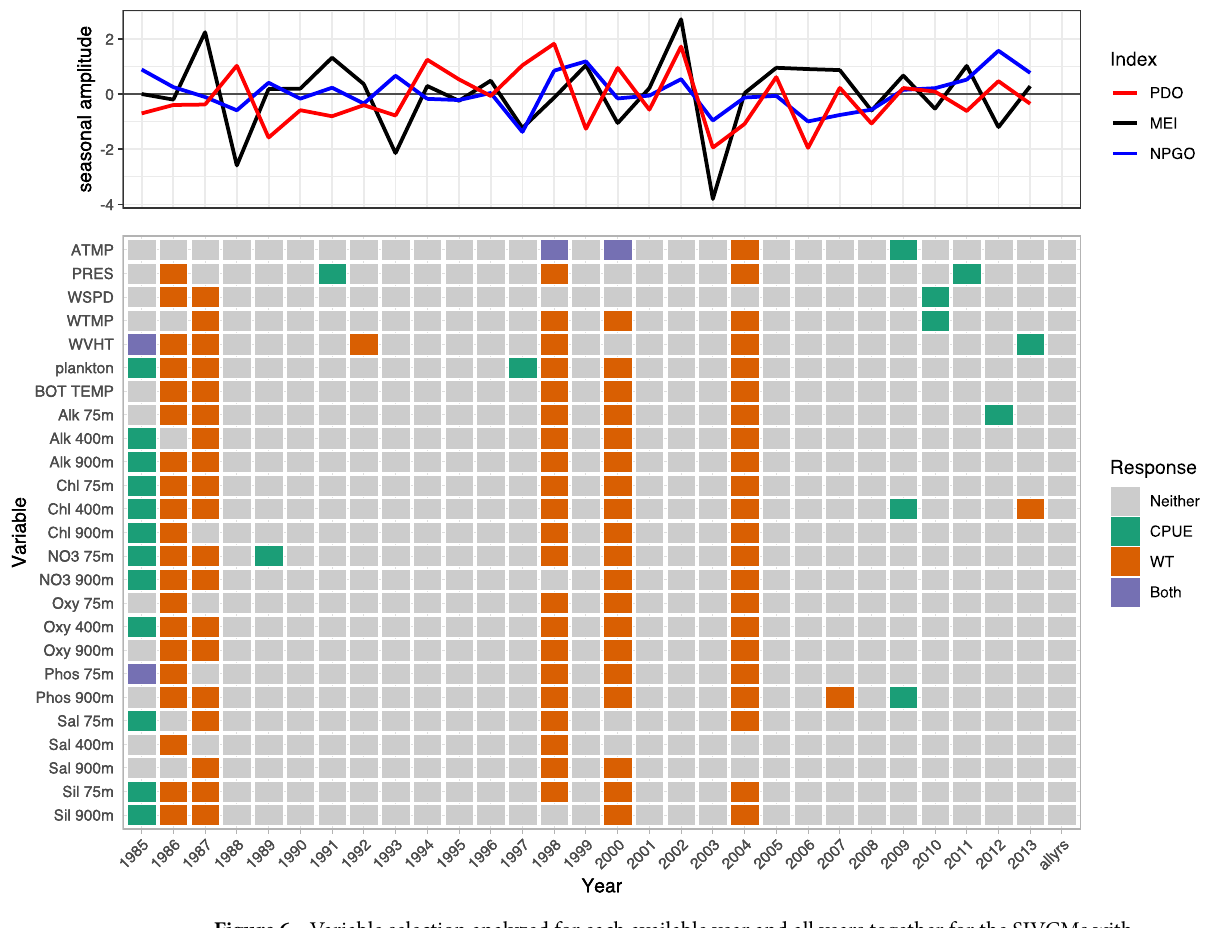
Figure 6. Variable selection analyzed for each available year and all years together for the SIVCMs with shortspine thornyhead CPUE or WT as the response. Axes, colors, and line plot are as described in Fig. 1.